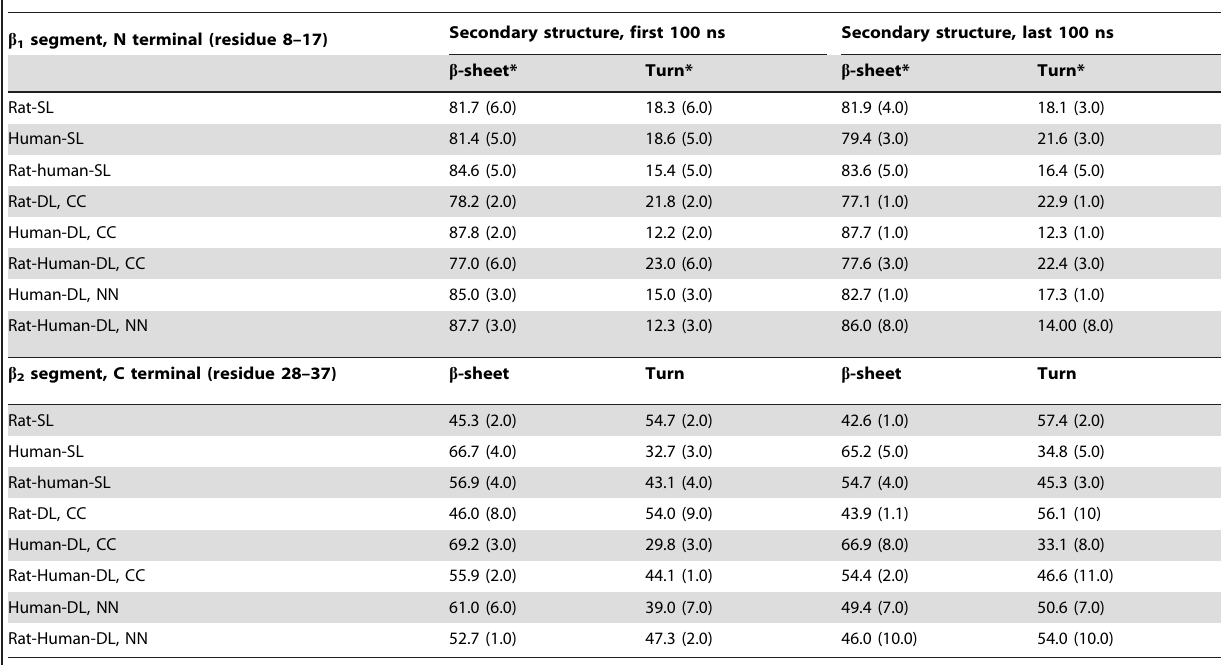
Table 4. Average secondary structure content from the first (0 2 100 ns) and last (200 2 300 ns) 50 ns MD Simulations.